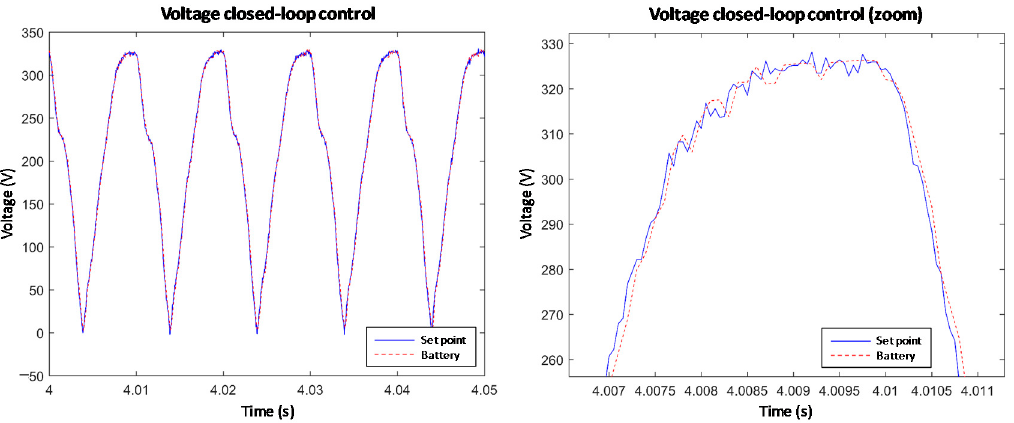
Figure 7. Output voltage control loop tracking the electrical grid.